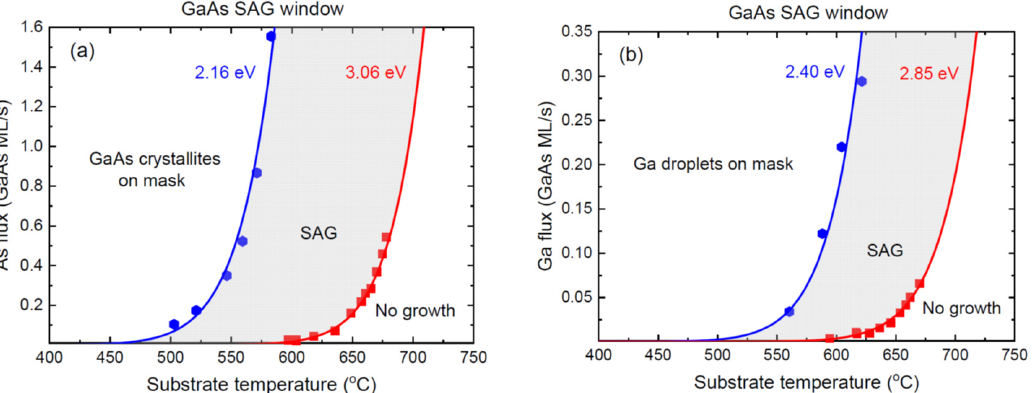
Figure 4. SAG windows for homoepitaxial GaAs SAG on GaAs(100): ( a ) As flux and ( b ) Ga flux versus temperature. Symbols represent the datapoints of Ref. [26], separating the SAG zone from the domains of parasitic nucleation of GaAs crystallites in ( a ) or Ga droplets in ( b ) when As or Ga fluxes are too high, and the no growth conditions for low fluxes. The lines correspond to the maximum and minimum fluxes obtained from Equation (24) with the effective activation energies shown near each curve.